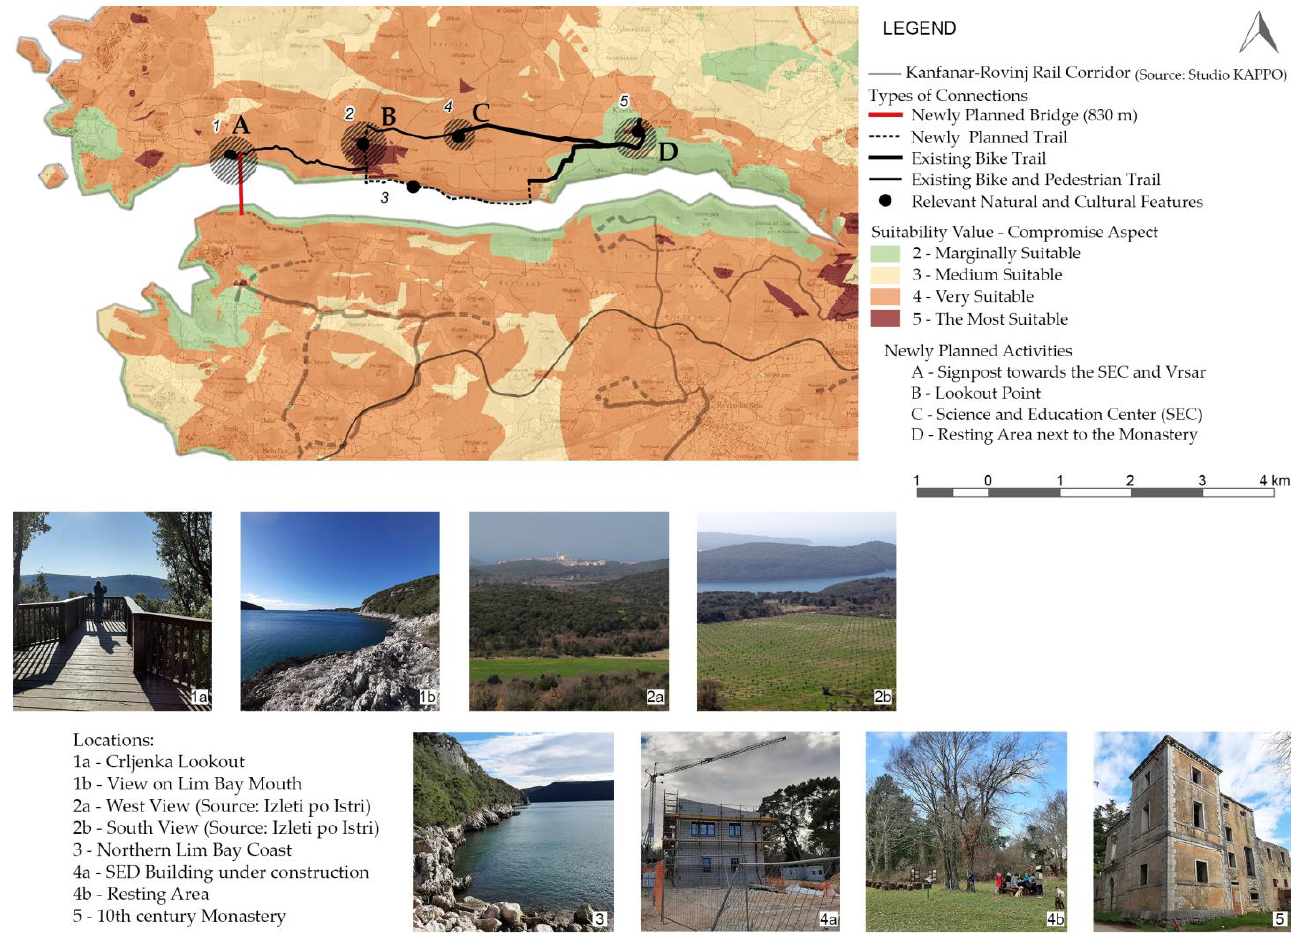
Figure 11. The Lim Bay functional area.